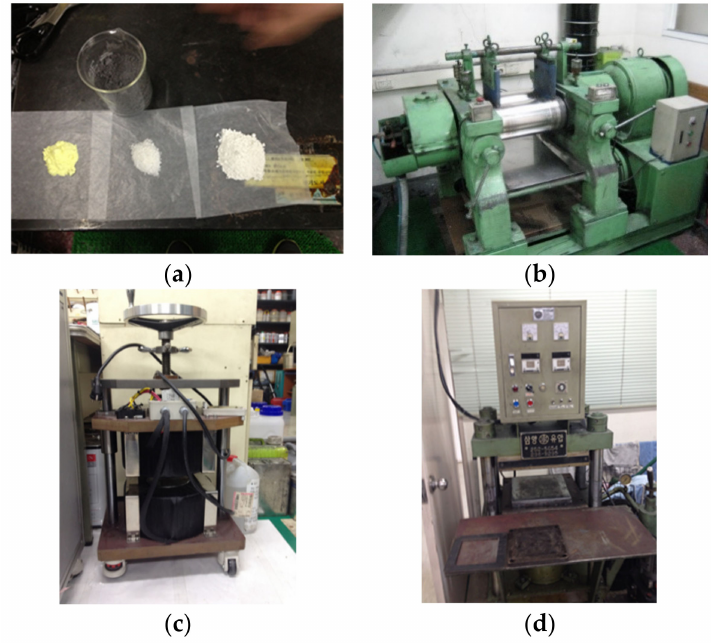
Figure 10. Process of MRE fabrication. ( a ) Composition of MRE materials, ( b ) roll-mill, ( c ) MRP Orientation, ( d )